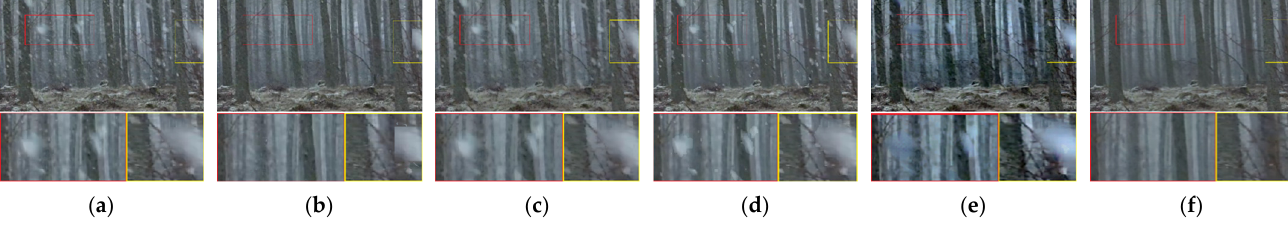
Figure 6. Comparison on a real snow video. ( a ) Input, ( b ) Kim et al. [16], ( c ) Wang et al. [8], ( d ) Li et al. [14], ( e ) Chen et al. [32], ( f ) proposed method.